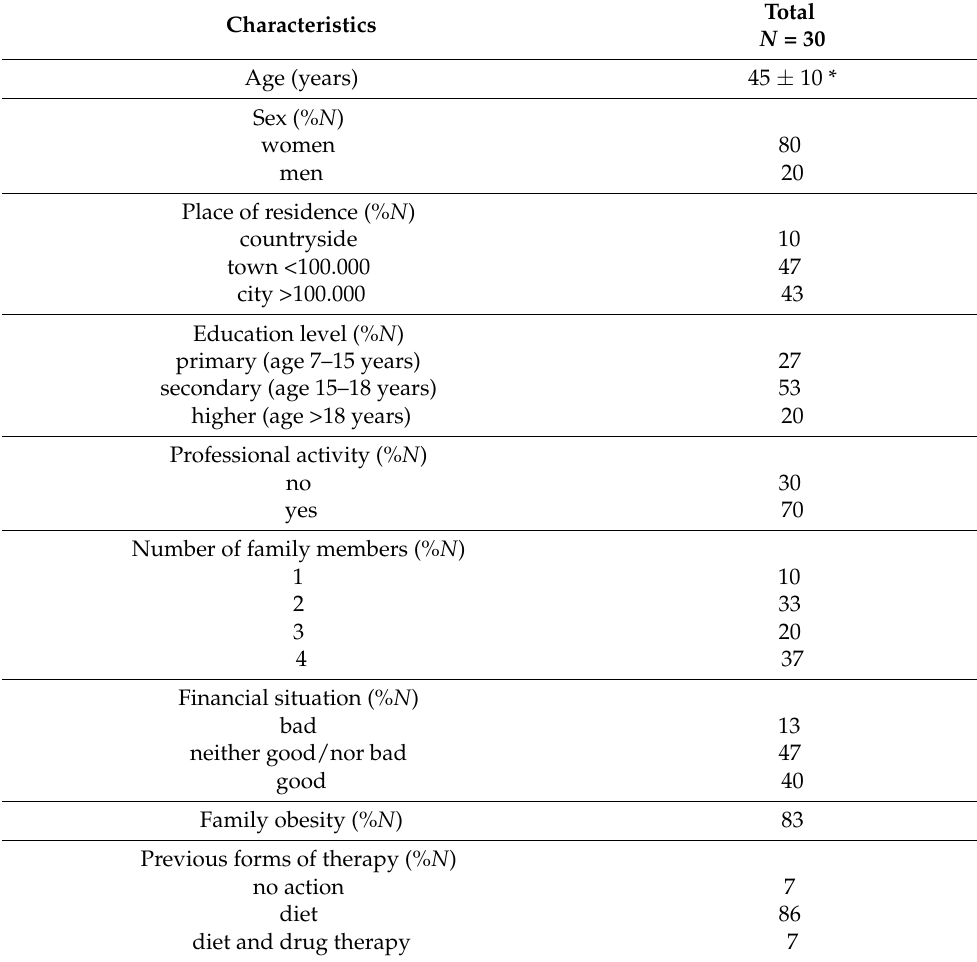
Table 1. Characteristics of